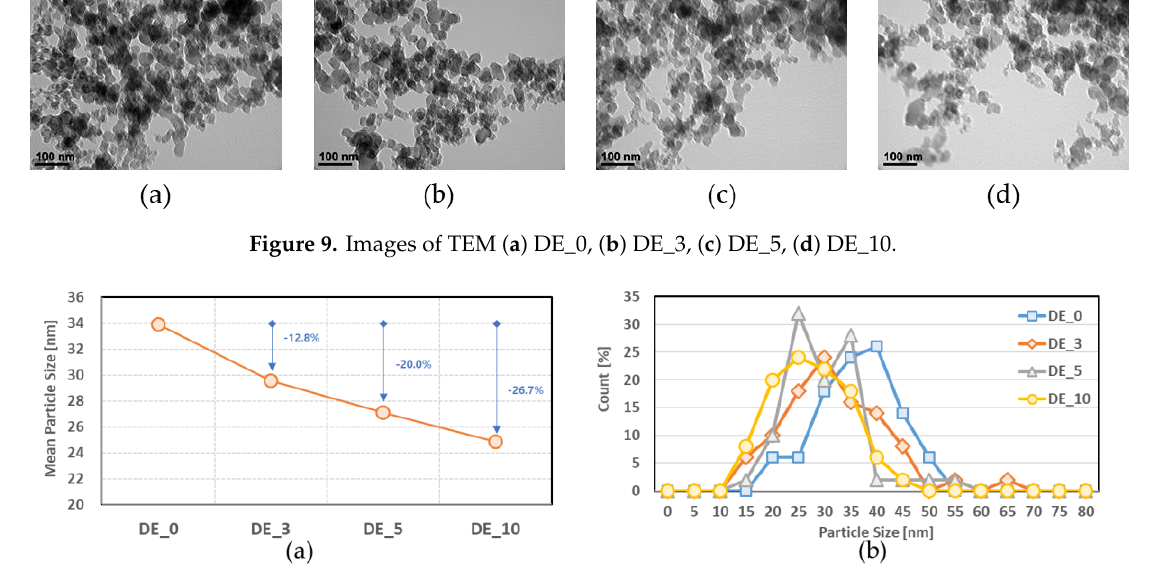
Figure 10. ( a ) Mean soot particle sizes, and ( b ) distributions of particles.